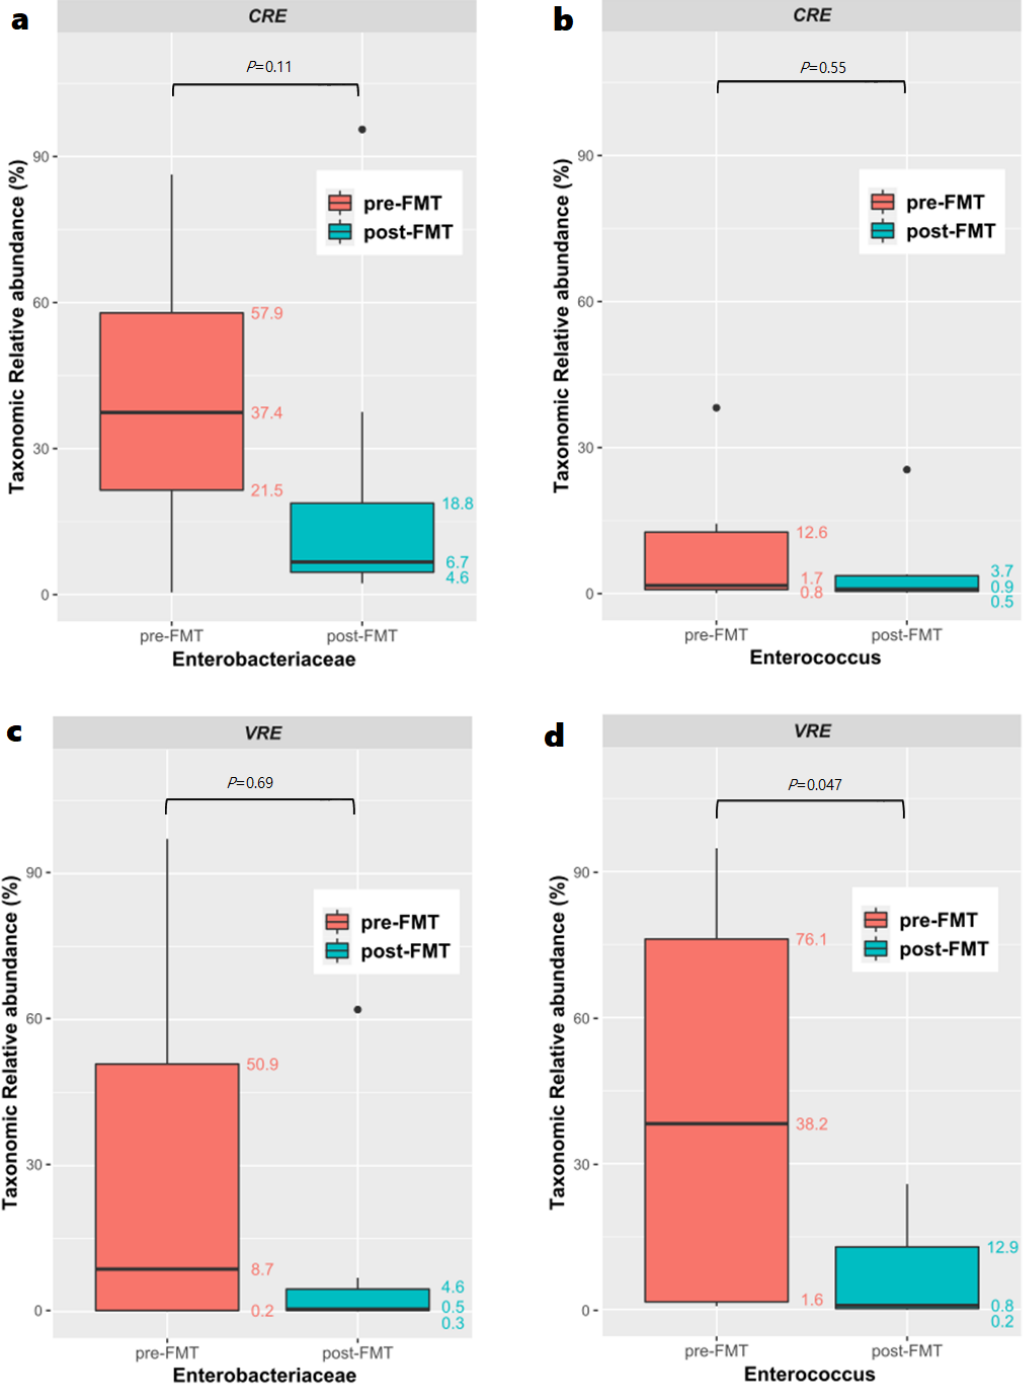
Figure 5. Comparison of the relative abundance of: ( a ) carbapenem-resistant Enterobacteriaceae (CRE) in the pre- and post-fecal microbiota transplantation (FMT) groups; ( b ) Enterococcus genus CRE in the pre- and post-FMT groups; ( c ) vancomycin-resistant Enterobacteriaceae (VRE) in the pre- and post-FMT groups; and ( d ) Enterococcus genus VRE in the pre- and post-FMT groups.